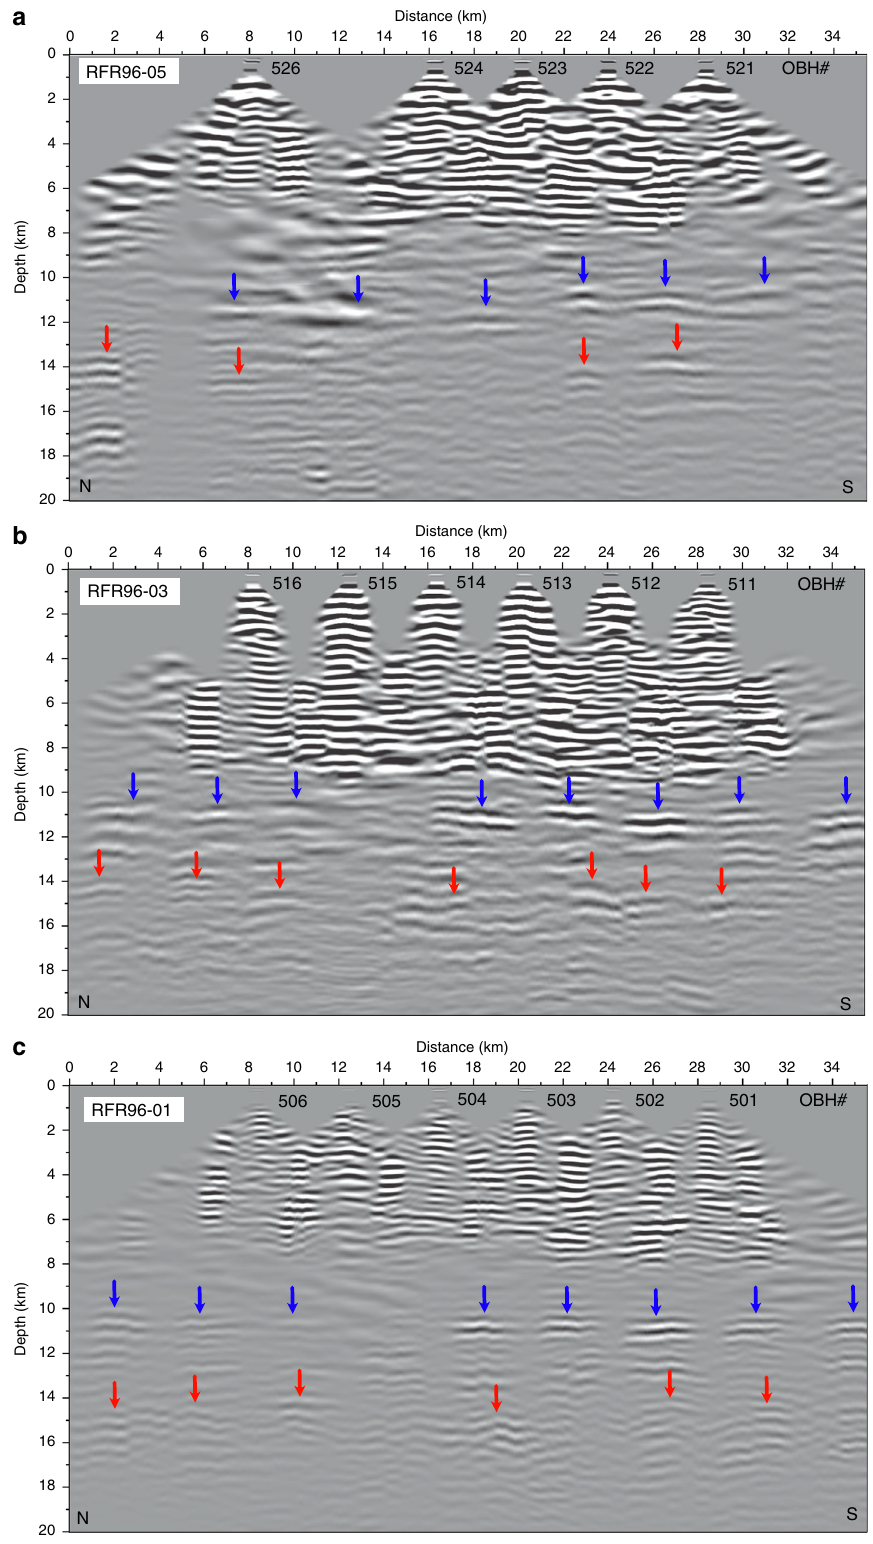
Fig. 3 Pre-stack depth migrated images of the OBH pro fi les. Prominent mantle re fl ections are indicated in blue (shallower) and red (deeper) arrows. a Pro fi le RFR96-05 sampling crustal age ∼ 0.9 Ma is shown. b Pro fi le RFR96-03, sampling crustal age of ∼ 1.65 Ma on average (please note that the line is crossing a propagator ’ s wake spanning crustal ages from 0.78 to 1.86 Ma). c Pro fi le RFR96-01 sampling almost uniform crustal age ∼ 2.67 Ma. The blue and red arrows mark the locations of the two re fl ectors. The OBH instruments, numbered (Fig. 1), are indicated at the top of each panel. For pro fi le RFR96-08 that samples ∼ 0.51 Ma old crust, weak and interrupted events in the mantle are observed (Supplementary Fig.